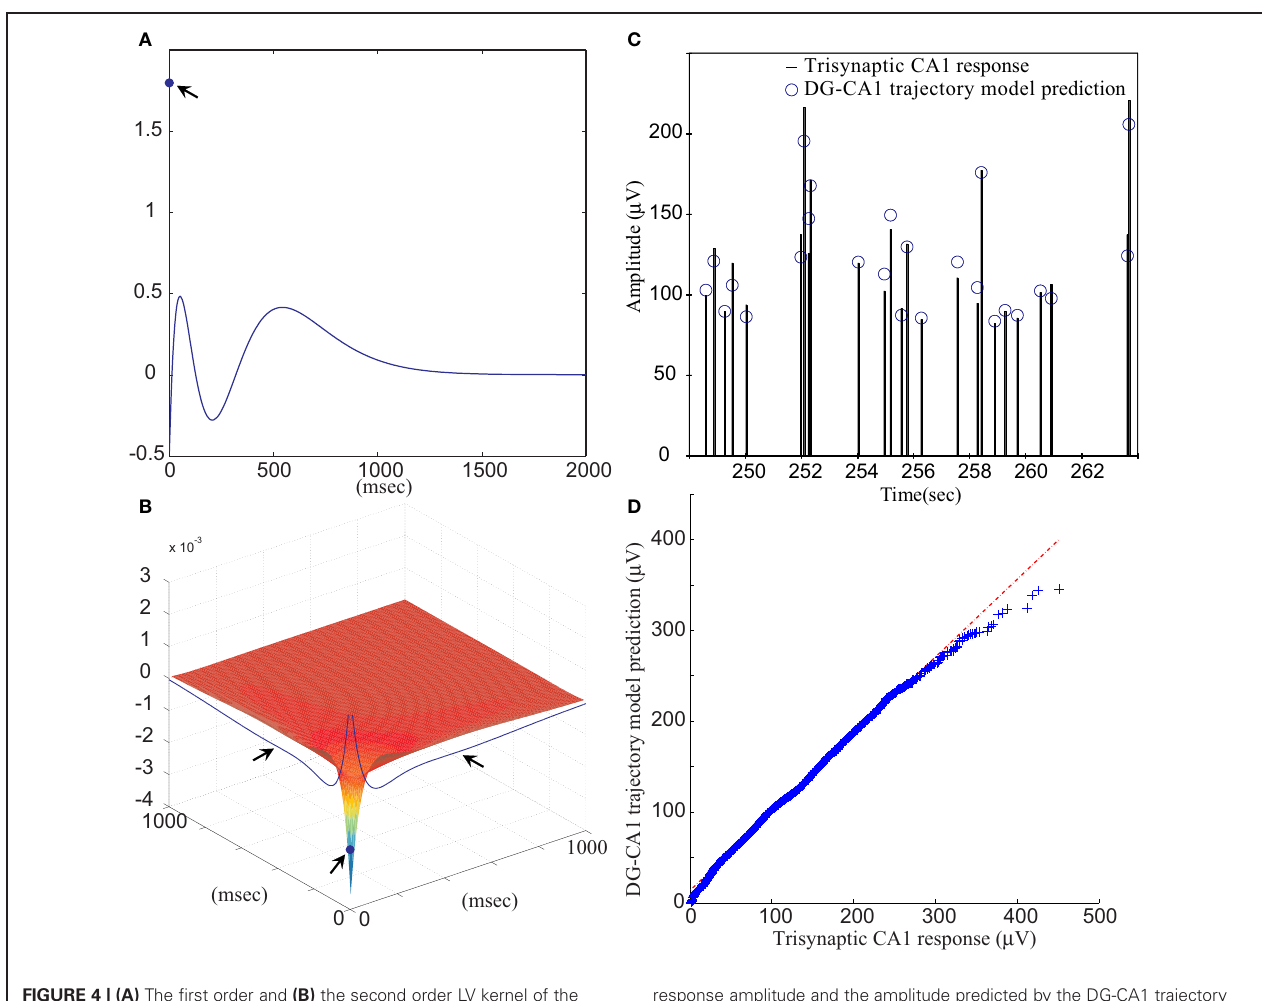
FIGURE 4 | (A) The first order and (B) the second order LV kernel of the DG-CA1 trajectory model. The singular points and lines showing on the edge of each figure (indicated by arrows) represent the effect of present input. (C) A segment of comparison between a FARIT-induced trisynaptic CA1